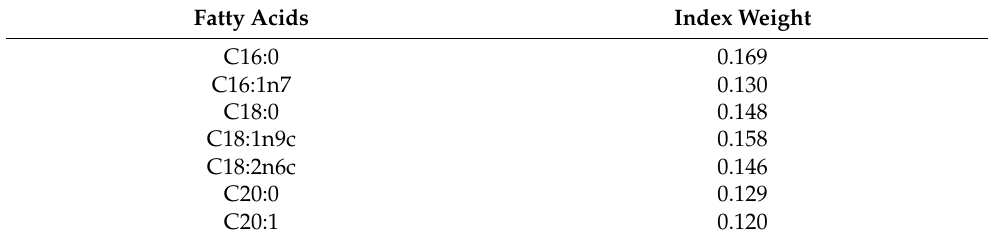
Table 8. Weight of different fatty acids in the quality evaluation of fresh sweet-waxy corn.